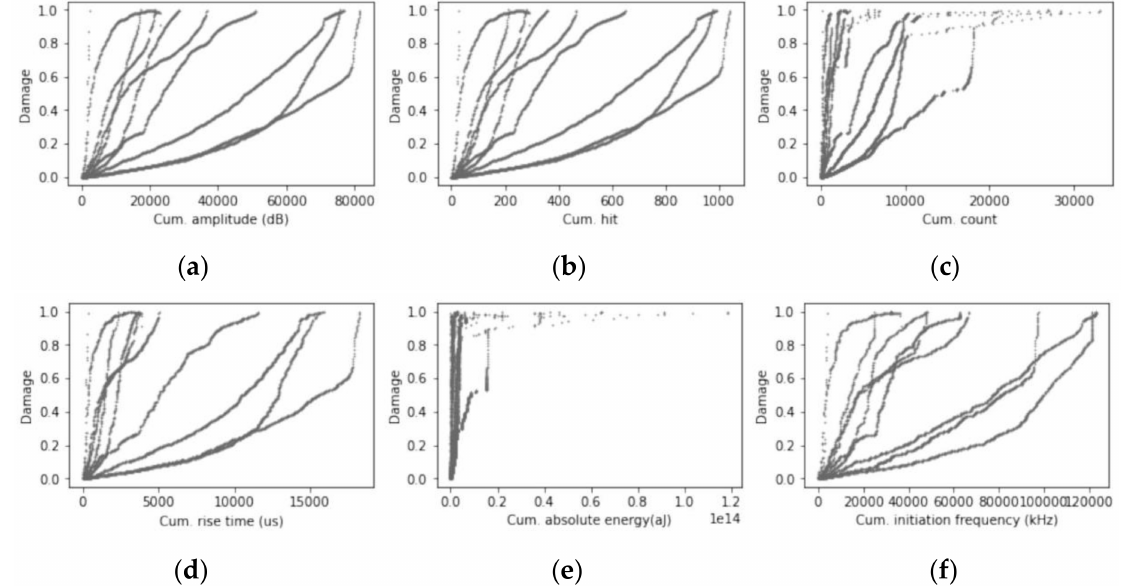
Figure 9. The changes of the damage for cumulative AE parameters such as ( a ) amplitude, ( b ) hit, ( c ) count, ( d ) rise time, ( e ) absolute energy, and ( f ) initiation frequency. Although 10 granite specimens were extracted from the same borehole in RG-2 section, the curves for each input showed different trends. This phenomenon seems to be due to the difference of properties such as rock strength, stiffness, and Poisson’s ratio and indicates that predicting the degree of rock damage using only one or two AE parameters is a difficult